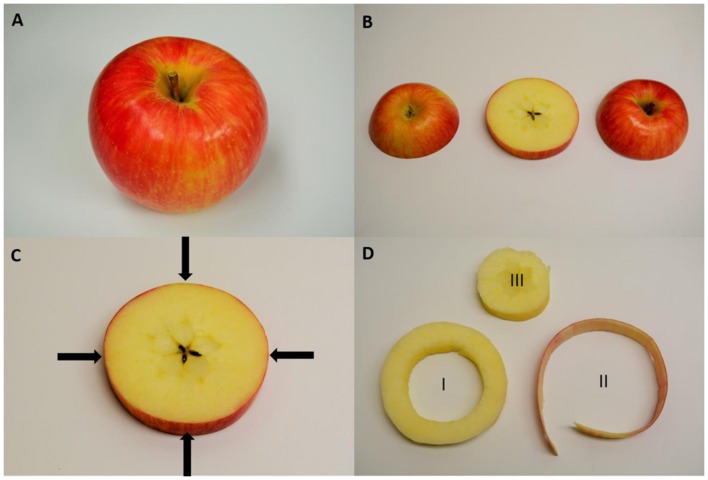
Sampling protocol of a ‘Honeycrisp’ apple for handheld x-ray fluorescence (XRF) and destructive lab sampling. (A) Whole apple where four measurements were made with the handheld XRF along the equator of the fruit. (B) To compare handheld XRF, an equatorial slice was removed from the apple. (C) A representation of the sampling locations for handheld XRF analysis. (D) Destructive sampling for elemental analysis of (I) the outer cortex of the apple used for analysis of homogenized pellets using the handheld XRF and then digesting for lab elemental analysis, (II) apple peel to compare with handheld XRF measurements made along the equatorial region of the fruit while it was whole, and (III) the core of the apple which was discarded.